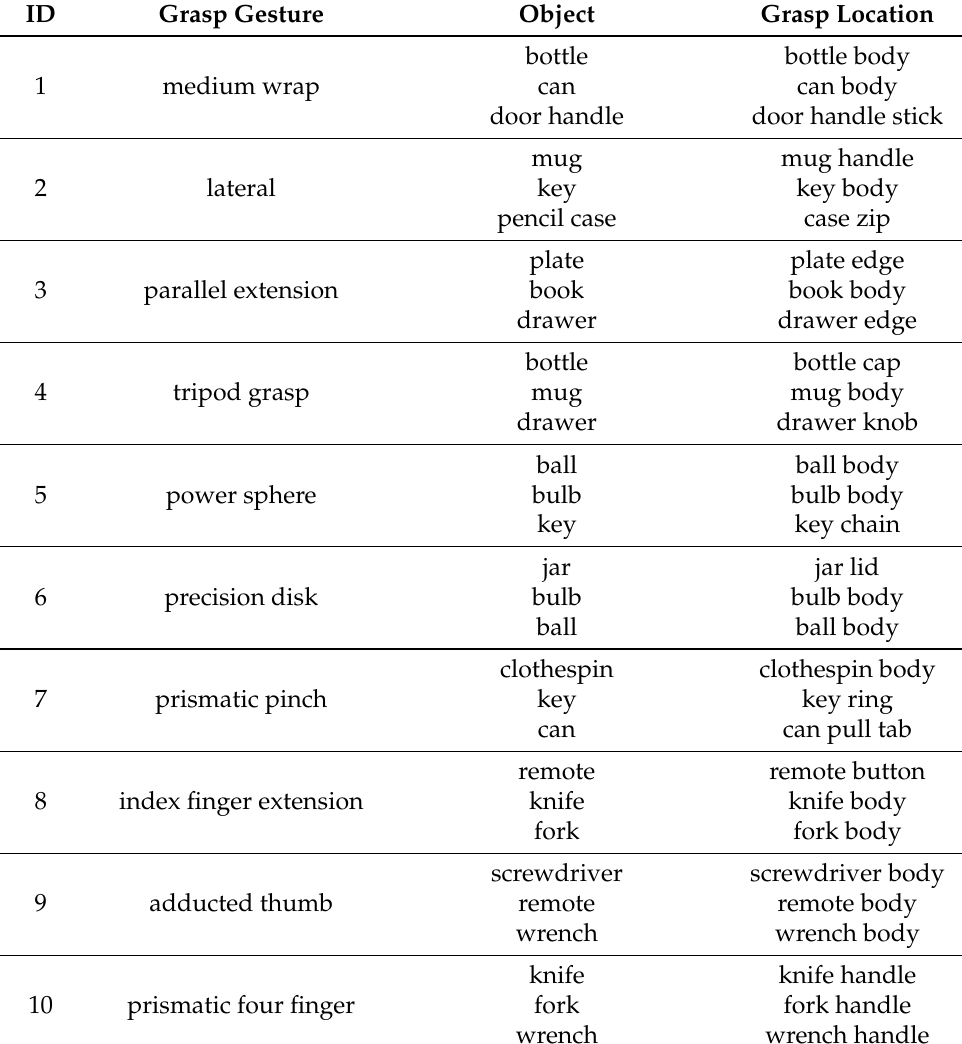
Table 1. The columns indicate the ID and name of the grasp gestures, the name of the object, and the name of the part of the object involved in the grasping. Adapted from ref. [13].